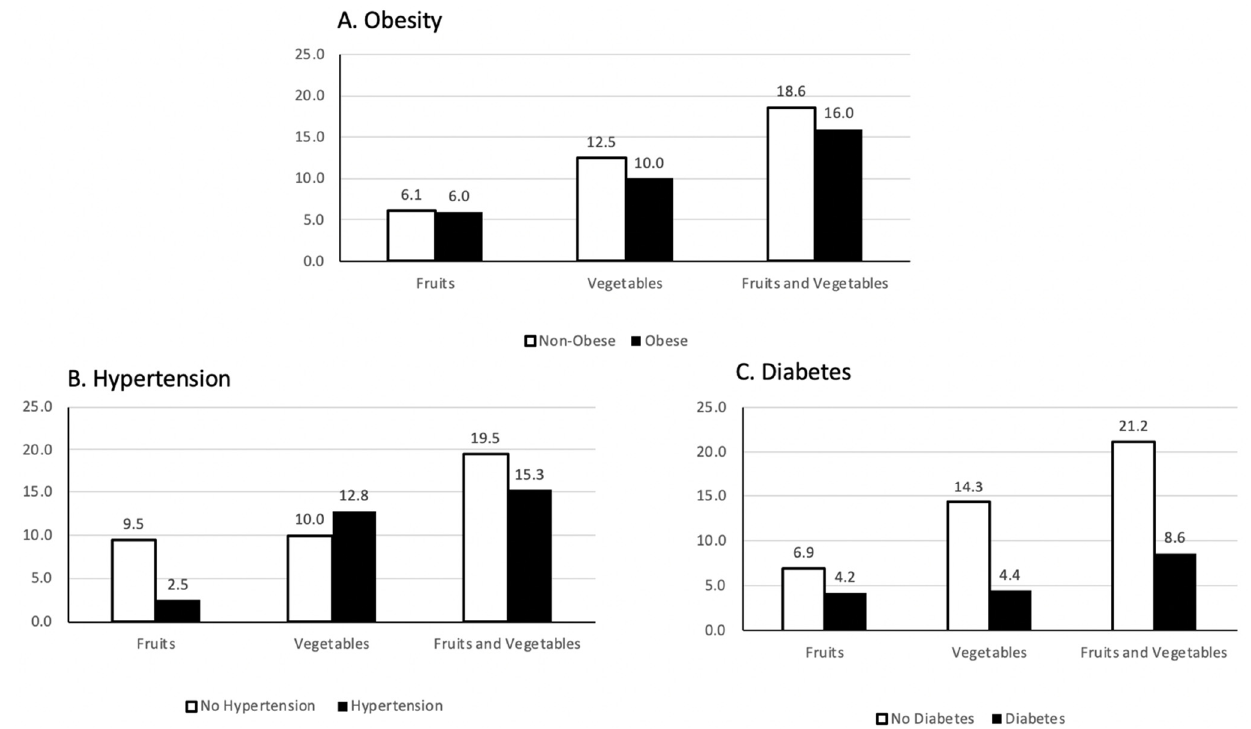
Figure 1. Percentage of participants adhering to the USDGA 2020–2025 recommendations of daily fruit (2 cups) and vegetable (2.5 cups) consumption by self-reported chronic disease among food pantry study participants ( n = 83). ( A ): Obesity; ( B ): hypertension; ( C ): diabetes. Table 3. Predicted intakes (mean ± SD) of food groups by self-reported chronic disease among food pantry study participants ( n = 83).